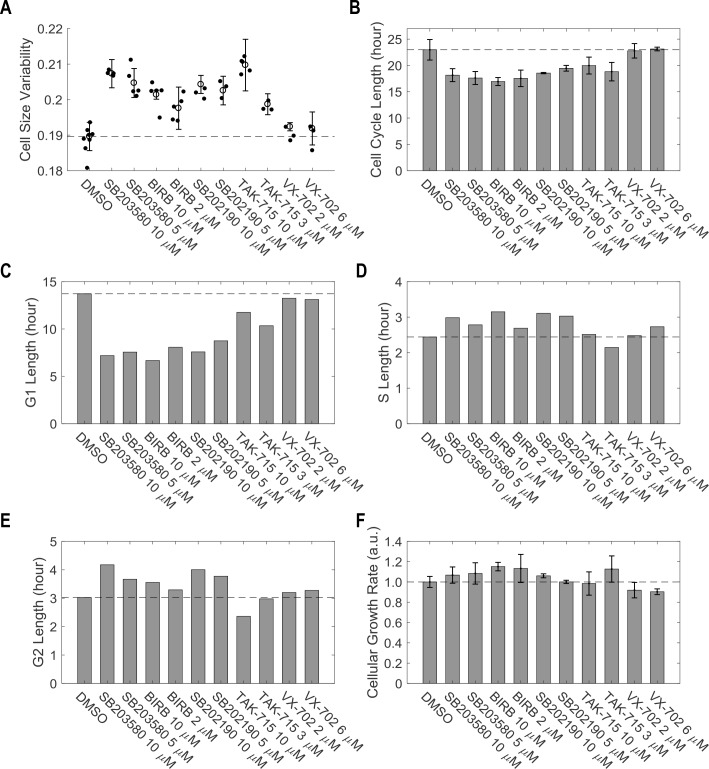
Inhibition of p38 MAPK increases cell size variability (A), promote proliferation (B) by shortening G1 length (C) without significant effect in S/G2 duration (D and E) or cellular growth rate (F).Measurements were performed with the same experiments as indicated in Figure 3B. Shown here is representative of three independent replicate experiments. The meta data and source code used to for the analysis is presented in Figure 3—source data 1.